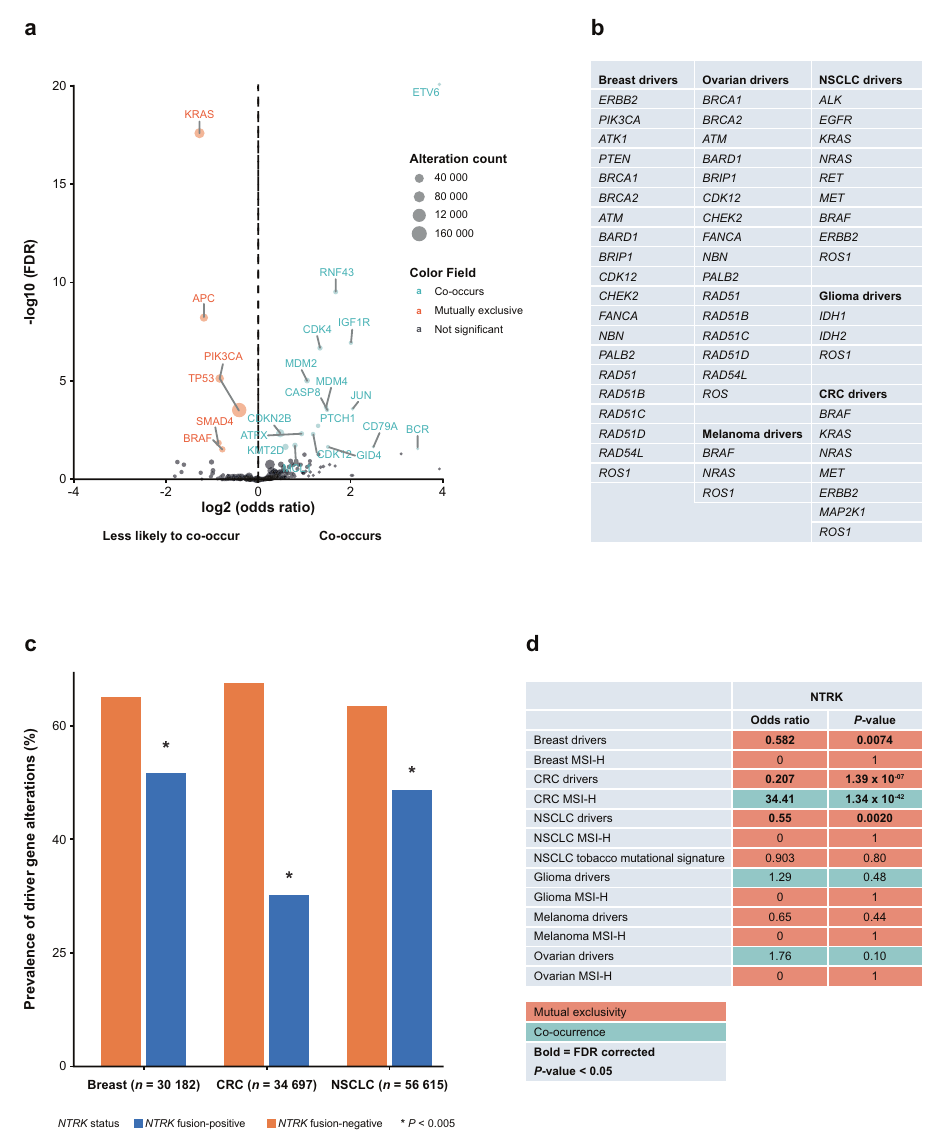
Fig. 3 Co-occurrence of genes among NTRK fusion-positive cancers. Co-occurrence of genes in all NTRK fusion-positive cancers ( a ). The prevalence of gene mutations was compared for NTRK fusion-positive and fusion-negative disease. Co-occurrence refers to genes that occurred in NTRK fusion-positive disease with an odds ratio greater than 1 compared with NTRK fusion-negative disease and the false discovery rate (FDR)-adjusted P -value was <0.05. Lack of co-occurrence refers to genes that did not occur in NTRK fusion-positive disease with an odds ratio less than 1 compared with NTRK fusion-negative disease and the FDR-adjusted P -value was <0.05. List of known disease-speci fi c driver genes for different tumour types ( b ). The frequency of mutations found within driver genes listed in b in NTRK fusion-positive and NTRK fusion-negative colorectal cancer (CRC), breast cancer and non-small cell lung cancer (NSCLC; c ). Summary of co-occurrence and mutual exclusivity of driver gene mutations and microsatellite instability-high (MSI-H) status with speci fi c NTRK fusion-positive cancers ( d ). NTRK neurotrophic tyrosine receptor